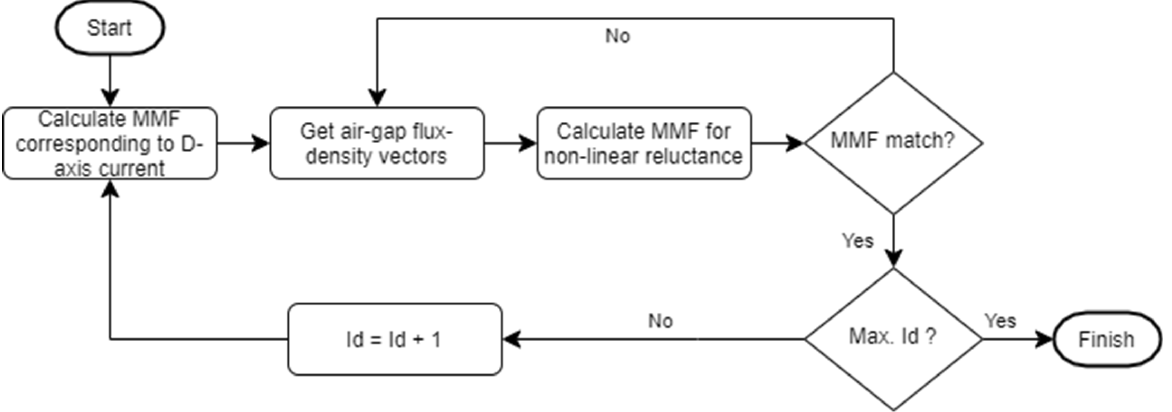
Figure 4. Calculation process for D-axis inductance in the case of a nonlinear MEC.